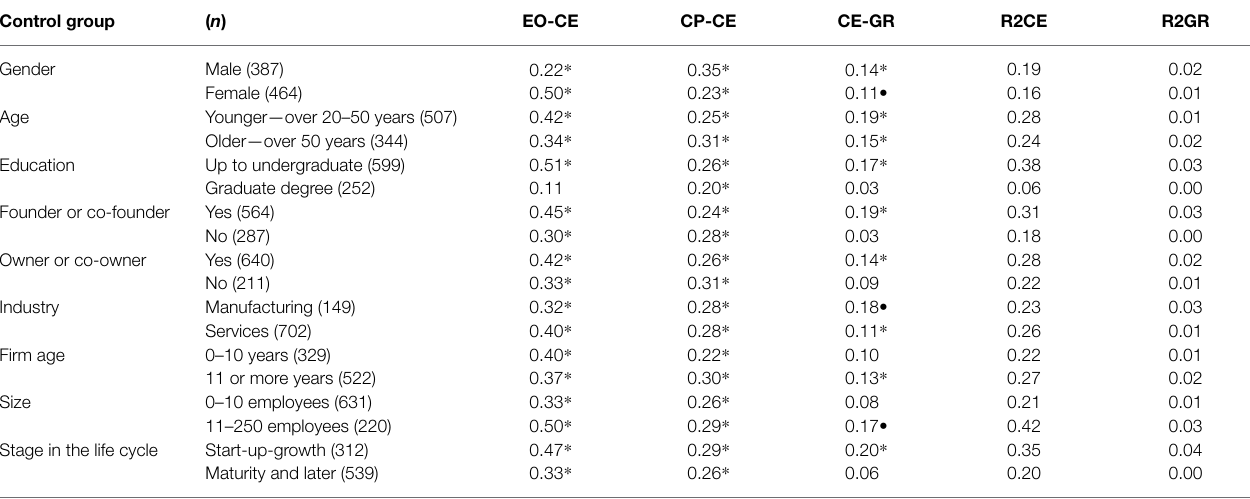
TABLE 8 | Structural equation modeling results—controls (coefficients and variance explained). Control group